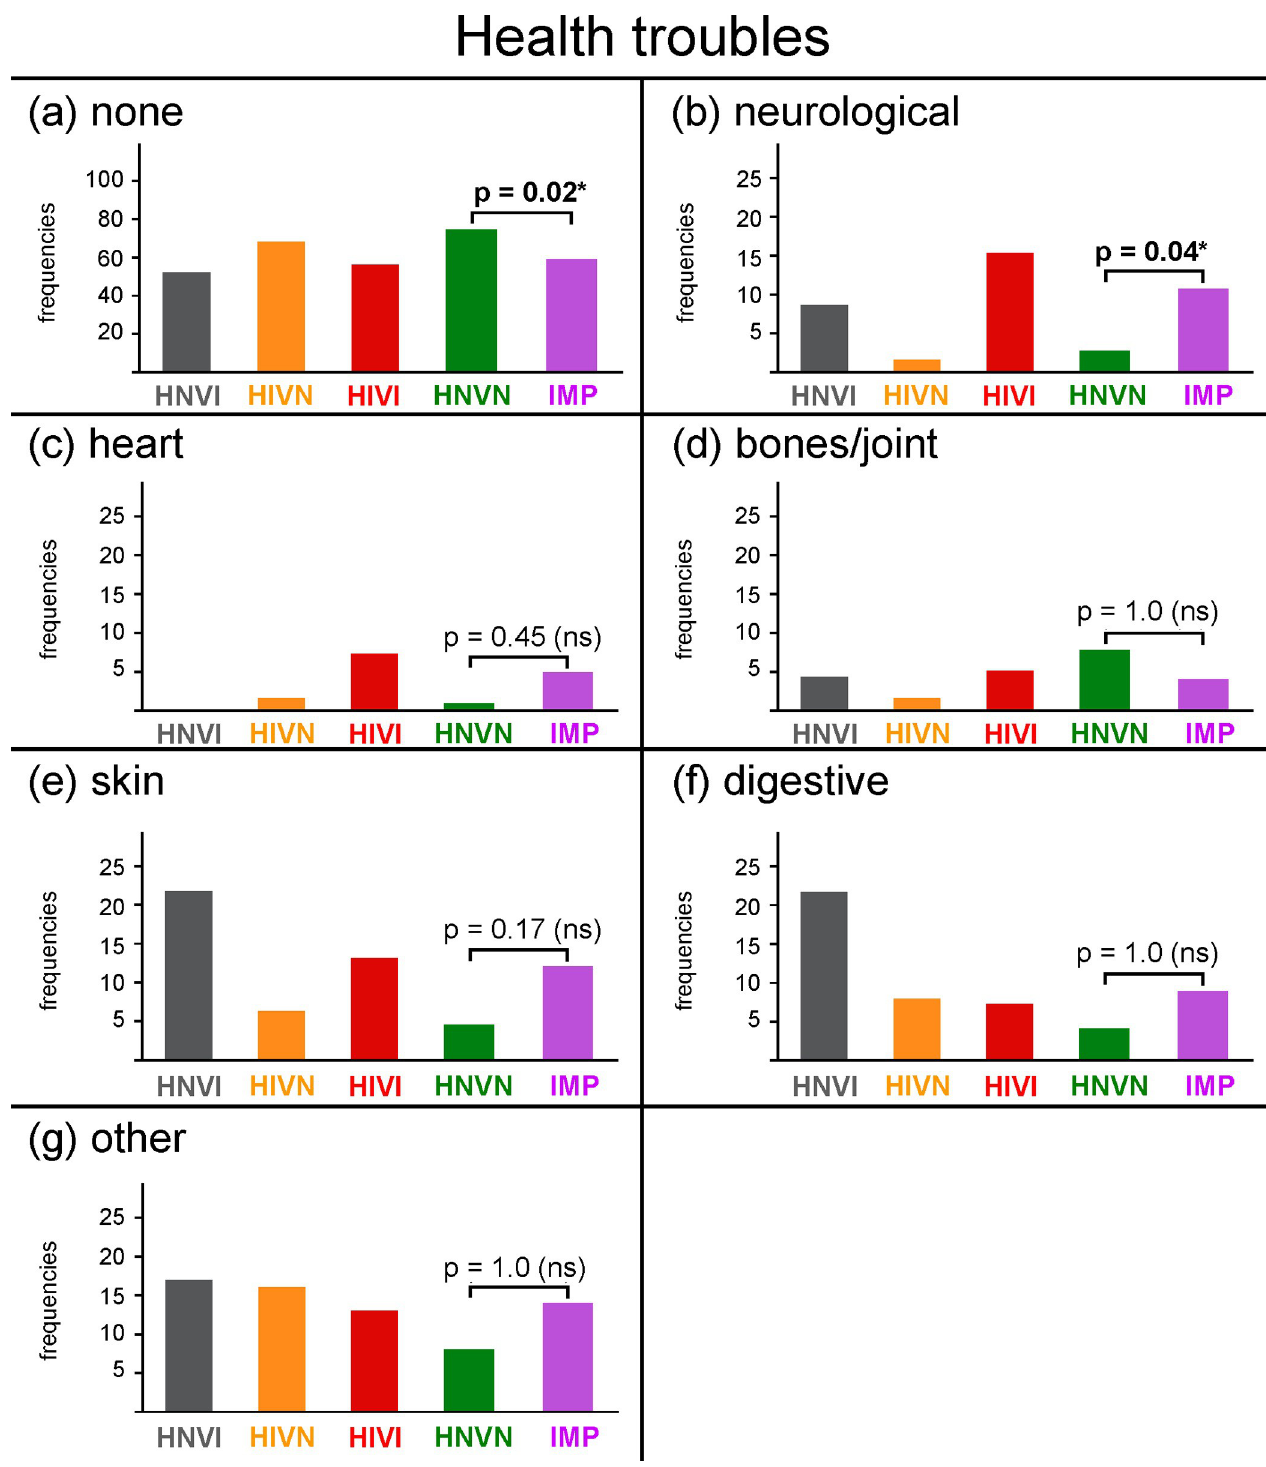
Fig 5. Frequencies of responses, in percentages, obtained for each group and for the IMP cohort for the following health troubles: (a) none, (b) neurological, (c) heart, (d) bones/joints, (e) skin, (f) digestive, and (g) other. The ordinate width is larger in panel (a) than in panels (b) to (g). HNVI = hearing normal vision impaired (grey), HIVN = hearing impaired vision normal (orange), HIVI = hearing impaired vision impaired (red), HNVN = hearing normal vision normal (green), IMP = impaired (HNVI, HIVN and HIVI gathered, purple), ns = not significant. Horizontal brackets show comparisons between HNVN and IPM assessed using Chi 2